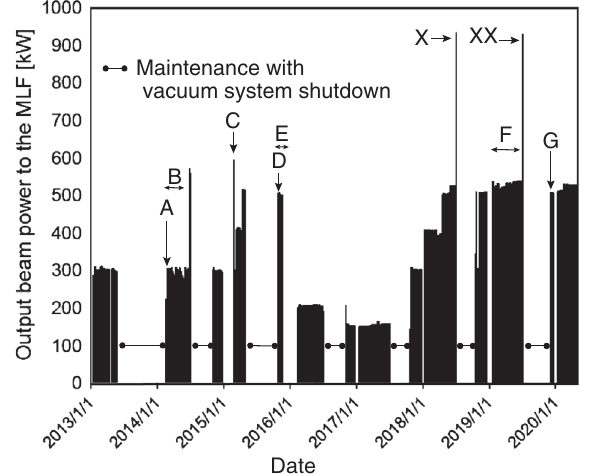
FIG. 14. History of the output beam power to the MLF from the RCS. Denotations A – G, X, and XX represent points, for which the dynamic pressures are analyzed in the present work.